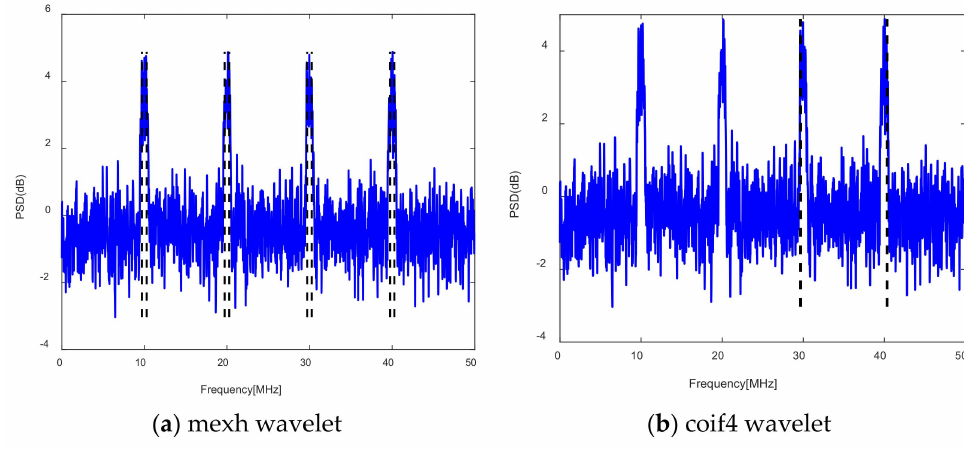
Figure 10. Modified CWT detection using different wavelet bases.